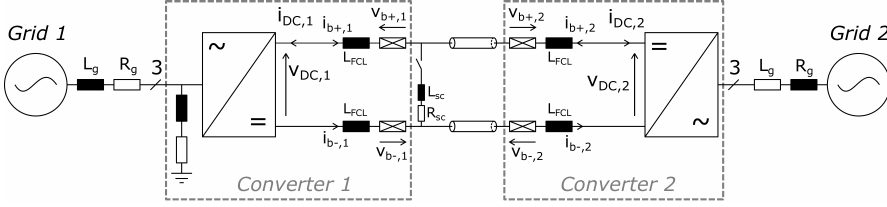
Figure 12. Detailed model of the HVDC link with DC circuit-breakers and notations. Table 5. Numeric data for the passive elements of the HVDC